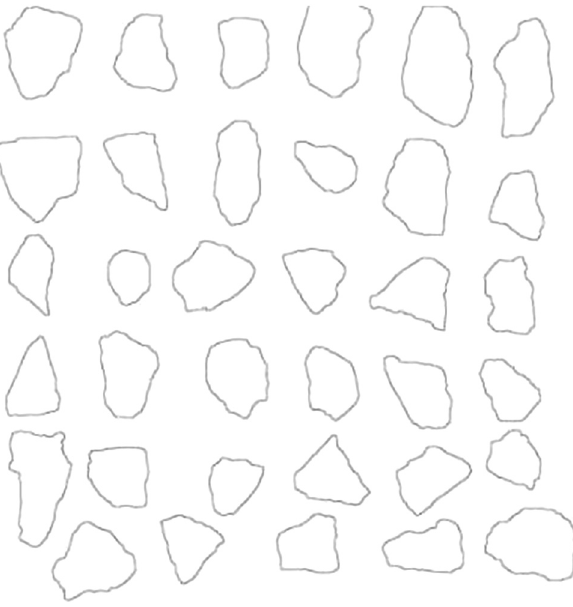
Figure 11: Boundary contour line of aggregate particle group.